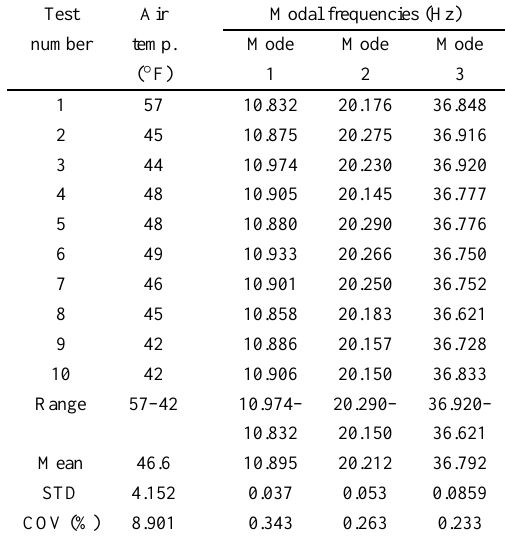
Random variation of modal frequencies for intact field